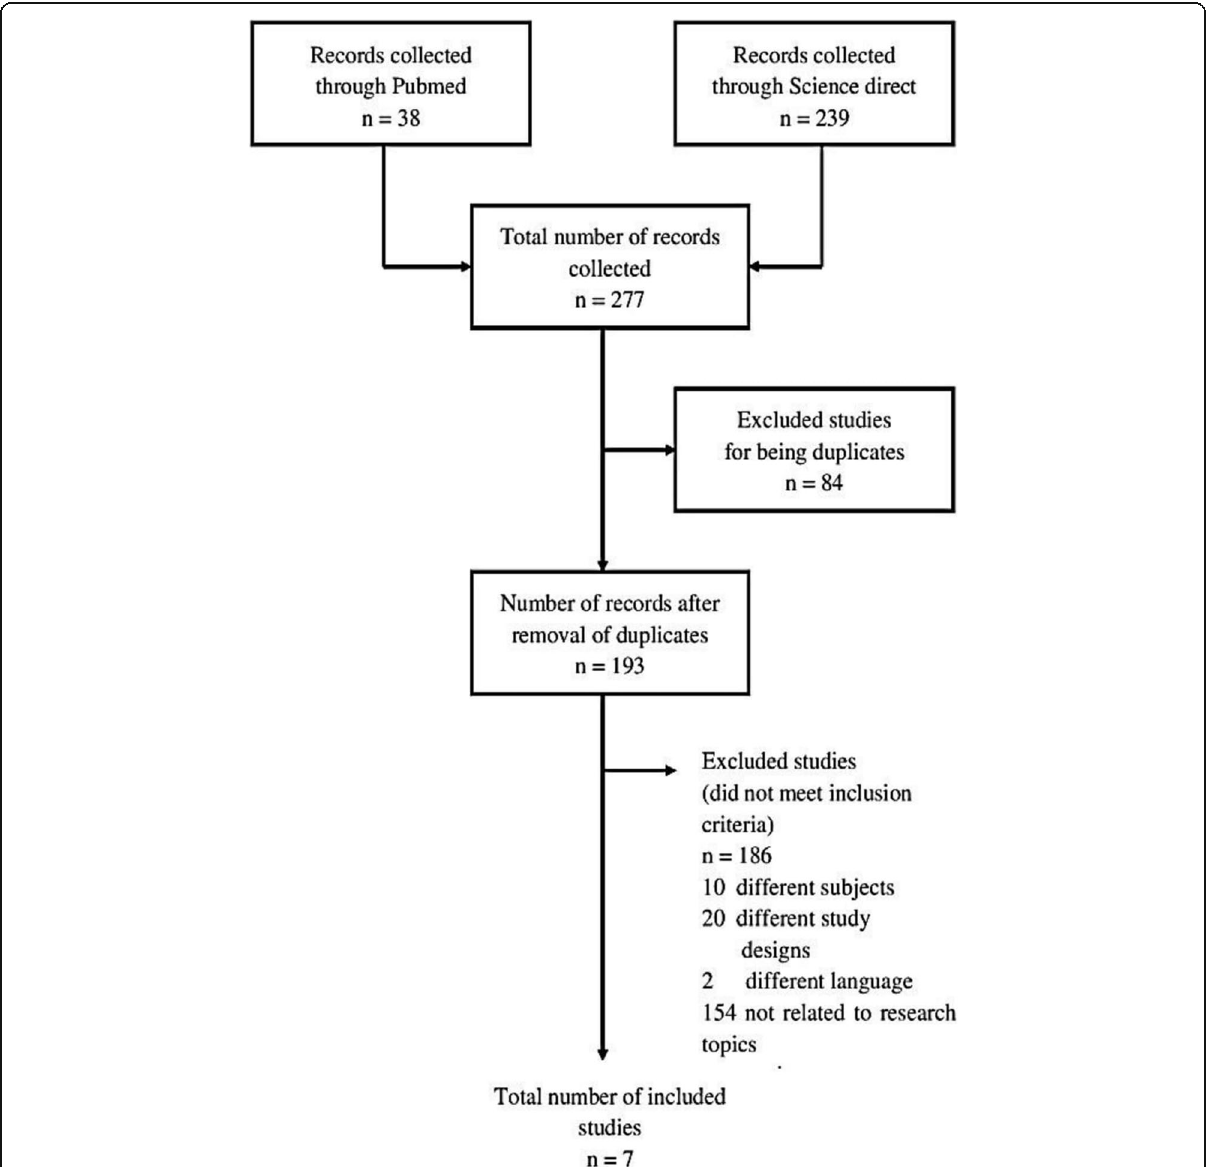
Fig. 1 The flow chart of excluded and included studies collected from our